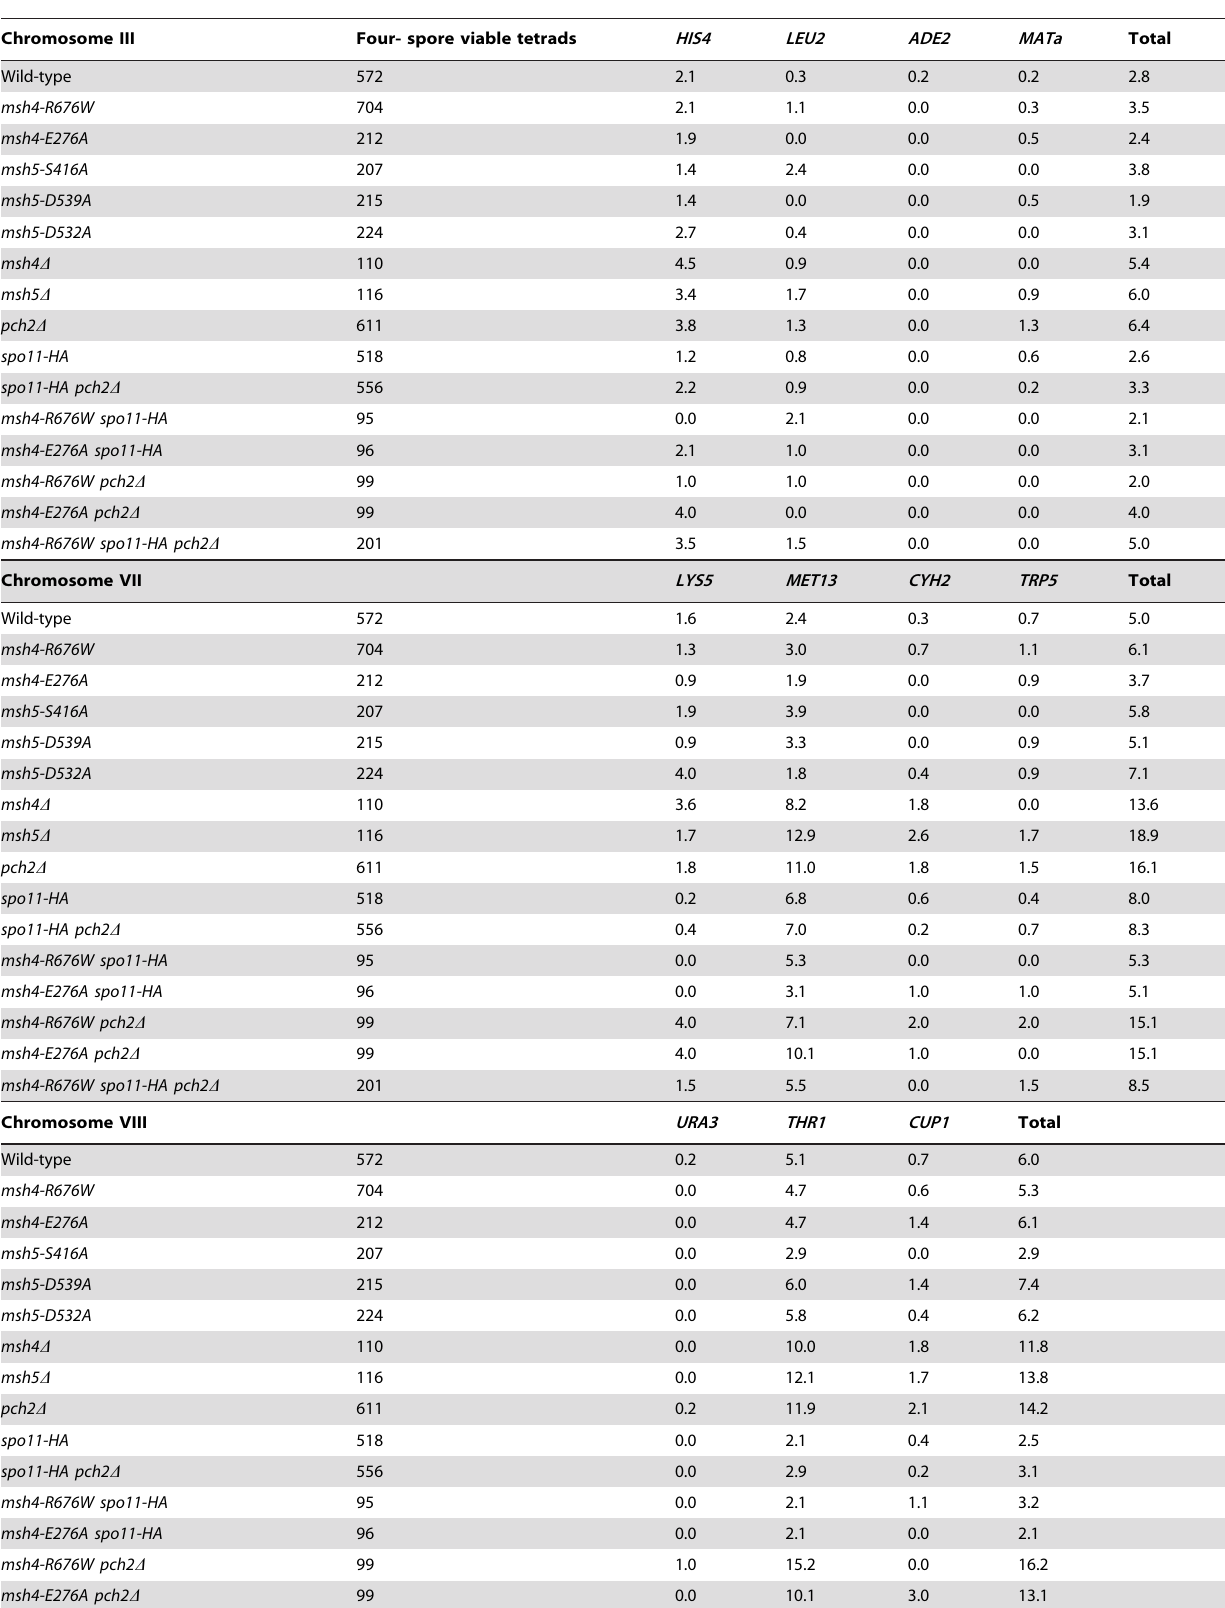
Table 3. Percentage of aberrant marker segregation in msh4 , msh5 mutants in the NHY942/NHY943 strain background.